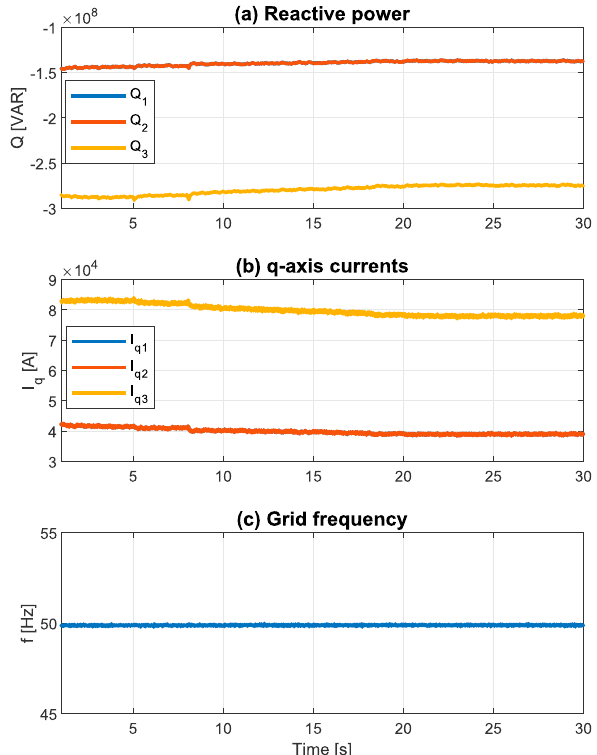
Figure 15. ( a ) Reactive power and ( b ) q-axis currents supplied by the individual inverters; ( c ) grid frequency.